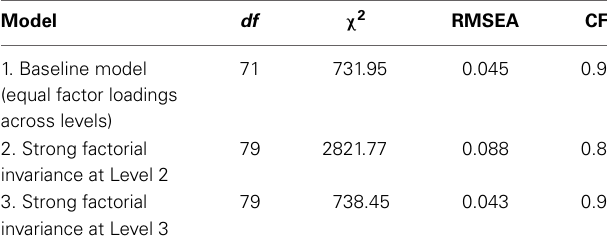
Table 1 | Fit measures of the three-level